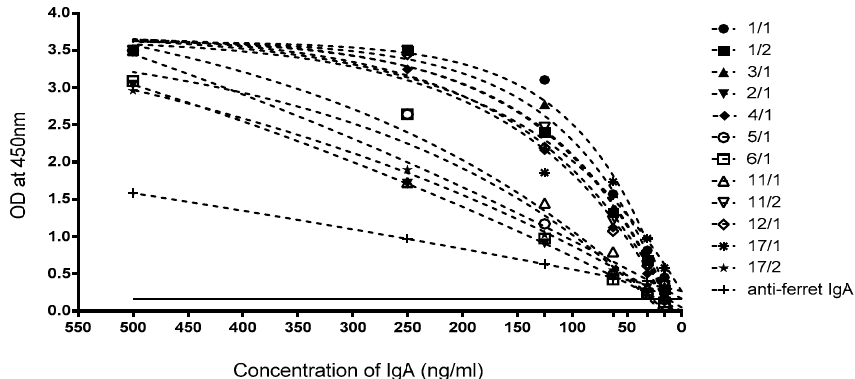
Figure 3. Titration of badger sIgA and recognition by anti-badger IgA monoclonals. Dashed lines show the fits to the data as one phase exponential decay curves (GraphPad Prism version 6.04 for Windows, GraphPad Software, La Jolla, CA, USA, www.graphpad.com). The goodness of fit (R 2 ) for these curves varied from 0.9482 (17 / 1) to 0.9999 (2 / 1). The solid line represents the background OD, (without the purified IgA), plus twice the standard deviation.